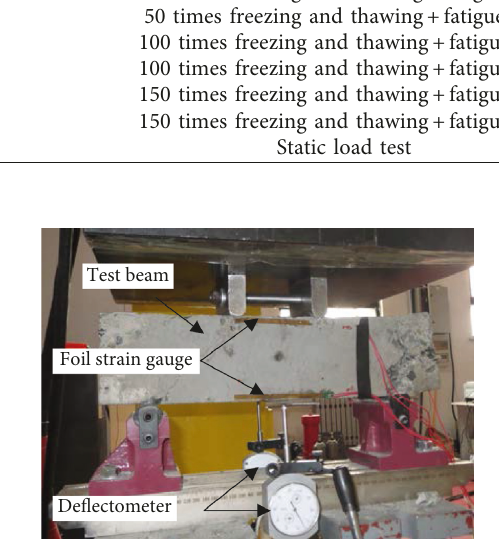
Figure 3: Loading